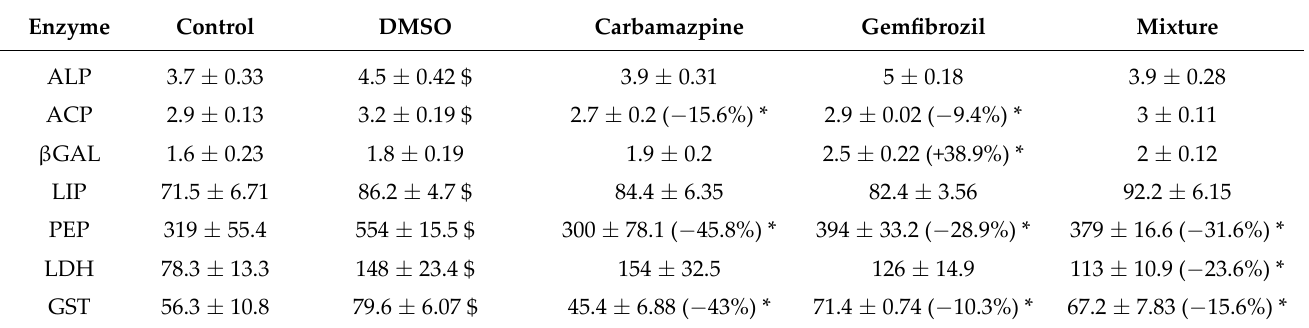
Table 3. The chronic impact of carbamazepine, gemfibrozil and their mixture on key enzyme activi‑ ties of